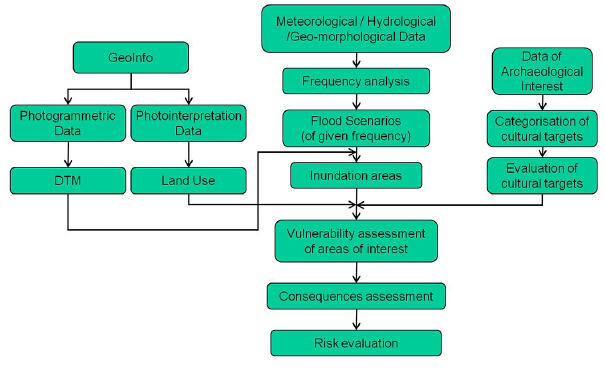
Figure 5. The flowchart of the procedure followed for the derivation of flood hazard and flood risk maps.